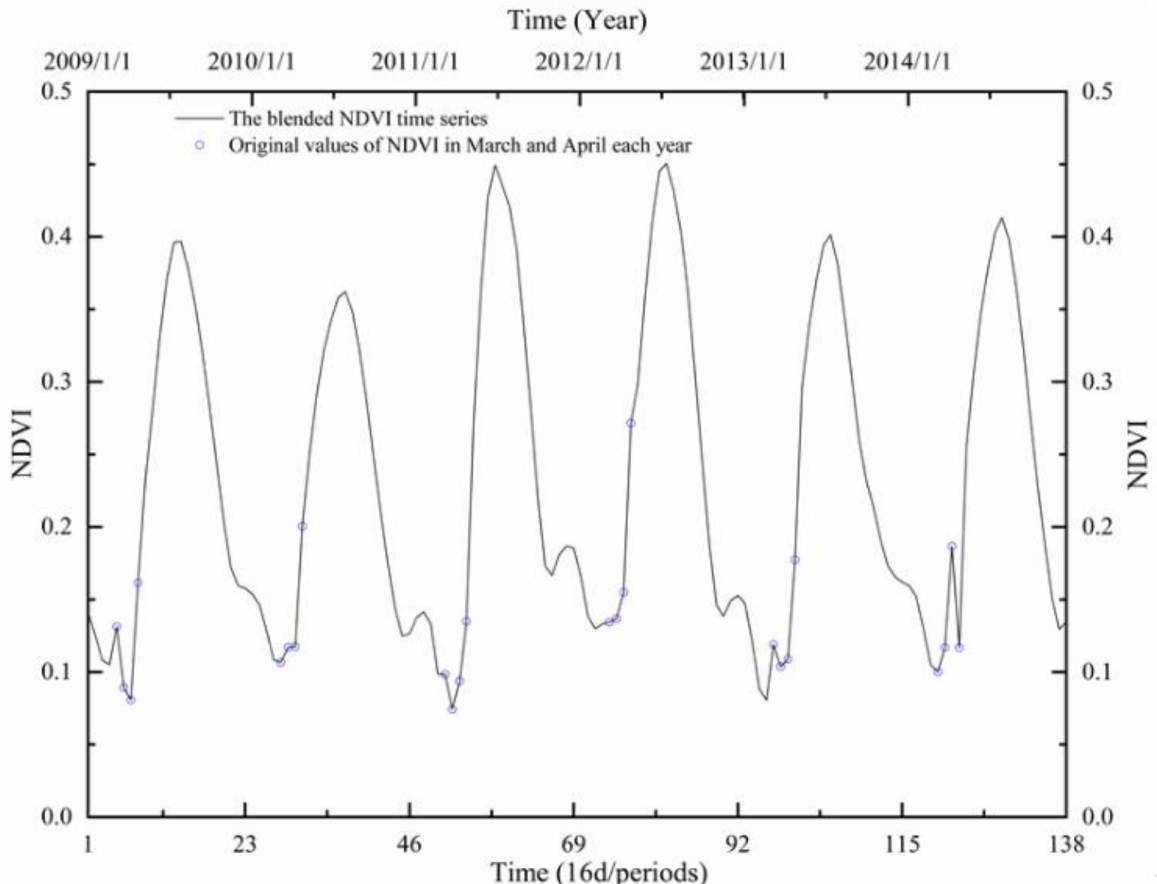
Figure 6. NDVI time series blended with pest disturbance